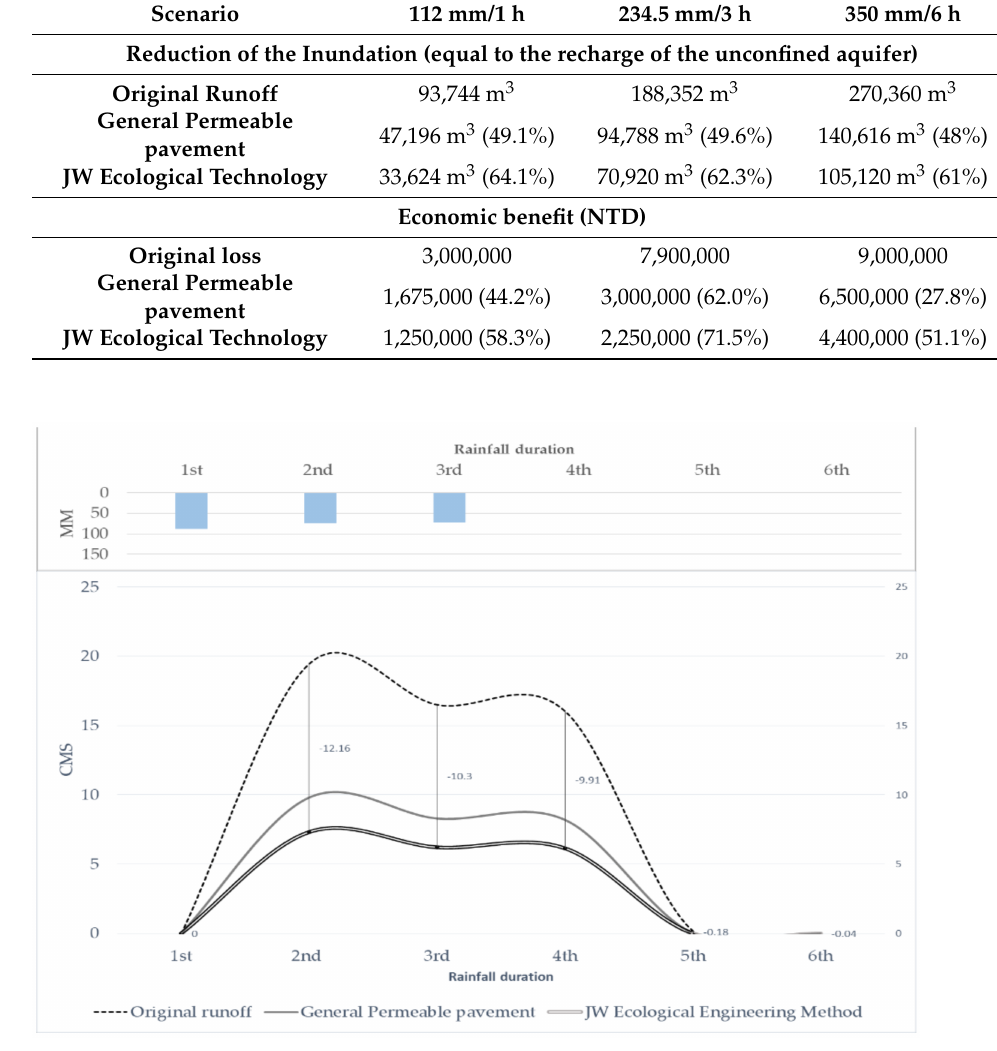
Figure 6. Simulation result for 3 h/234.5